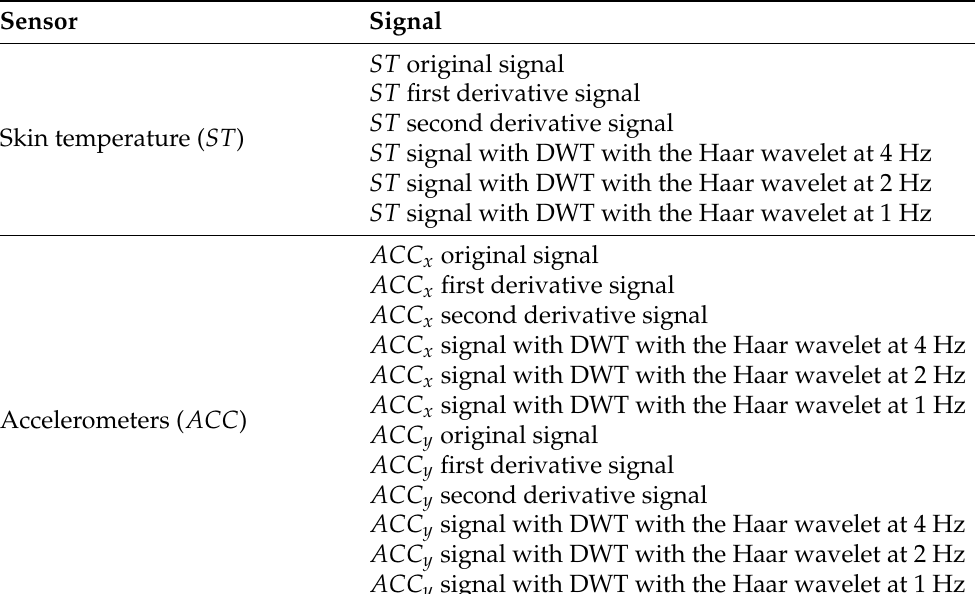
Table 2. Signal data used in this